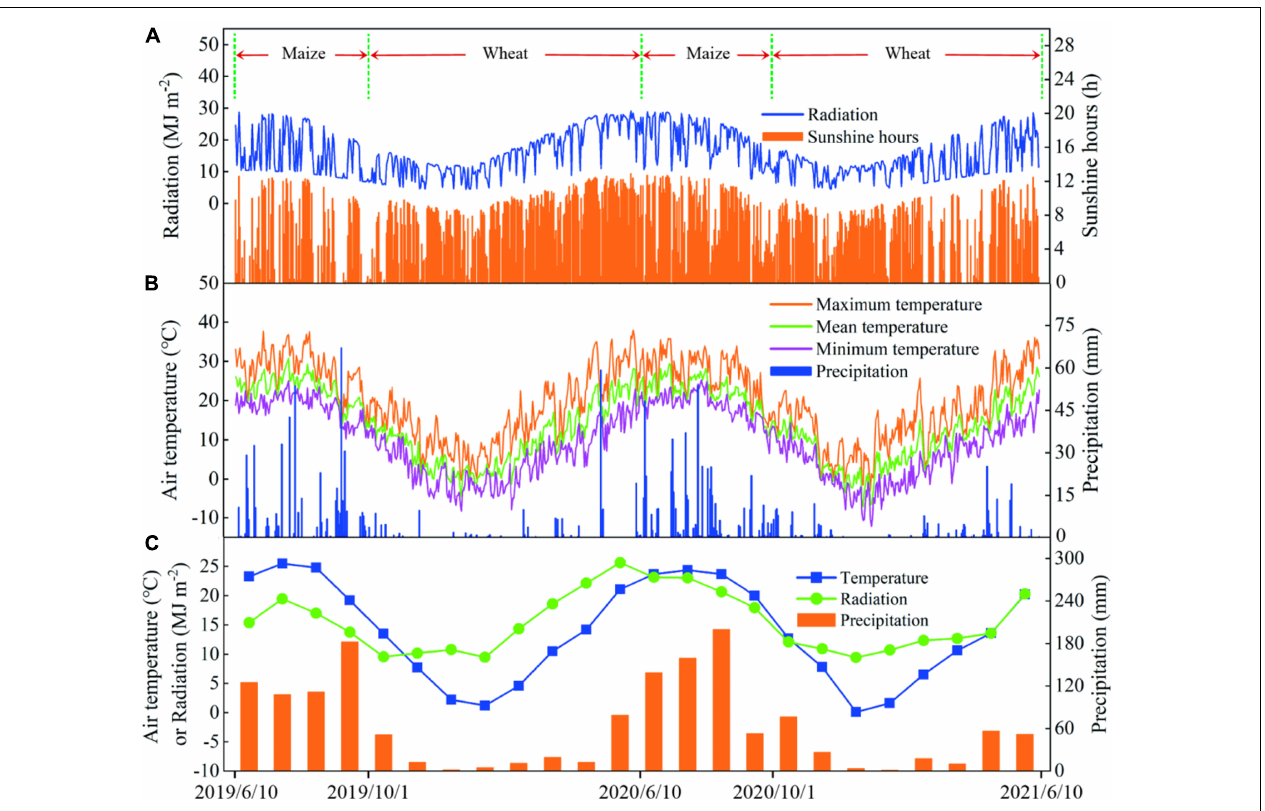
FIGURE 1 | Daily solar radiation and sunshine hours from 2019 to 2021 (A) ; daily temperature and precipitation (B) ; monthly average daily temperature, radiation, and monthly cumulative precipitation (C) .